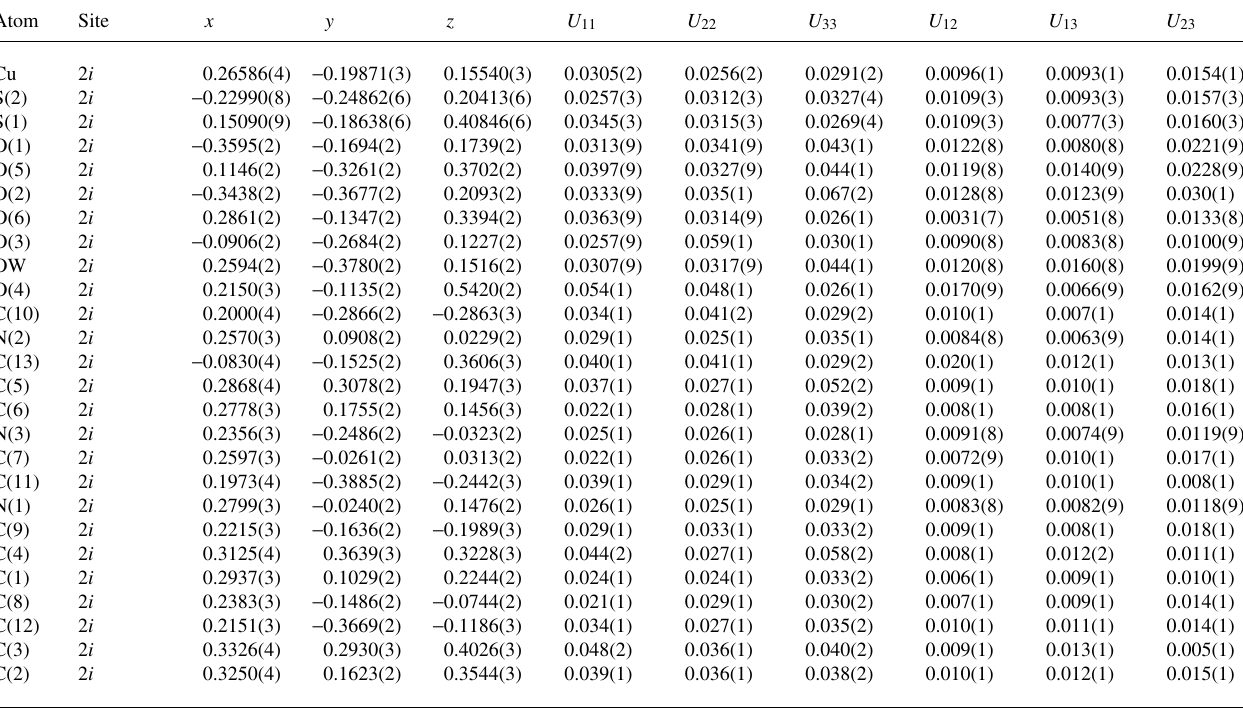
Table 3. Atomic coordinates and displacement parameters (in Å 2 )